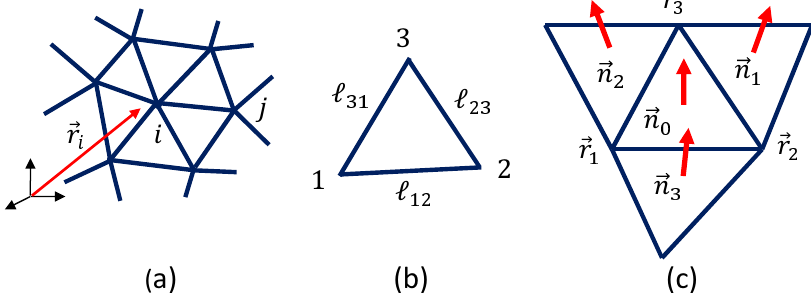
Figure 3. ( a ) A triangular mesh or lattice and the vertex position (cid:126) r i , ( b ) a triangle with vertices 1,2,3 and edge lengths (cid:96) 12 , (cid:96) 23 , (cid:96) 31 , and ( c ) the unit normal vectors (cid:126) n 0 of the triangle 123, and those (cid:126) n i , ( i = 1,2,3 ) of its neighboring triangles, where the su ffi x i denotes the corresponding